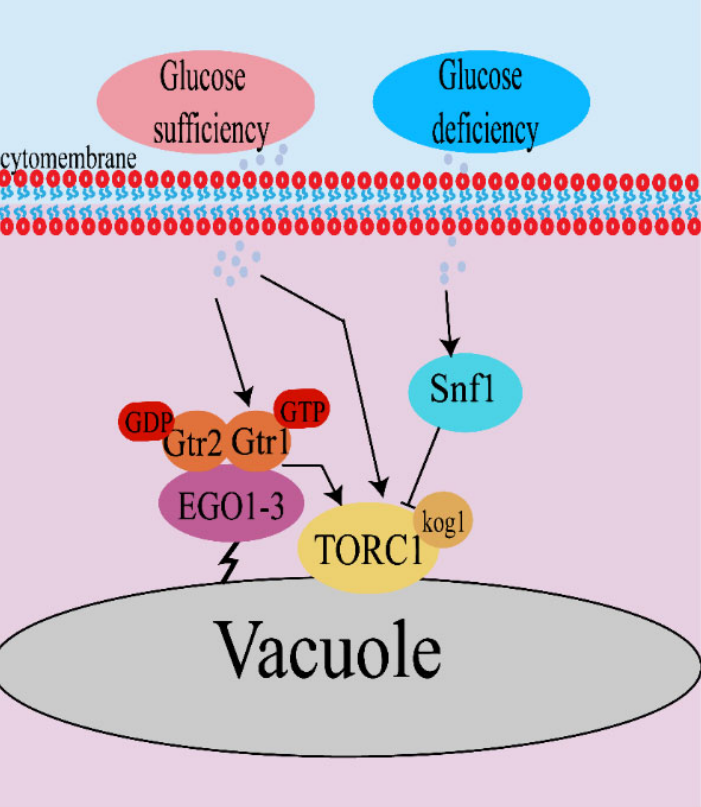
Figure 2. Glucose regulates TORC1 activity in S. cerevisiae. Under condition of glucose sufficiency, glucose activates TORC1 in both a Gtrs-dependent and -independent manner. Under condition of glucose deficiency, glucose can inhibit TORC1 activity via Snf1.